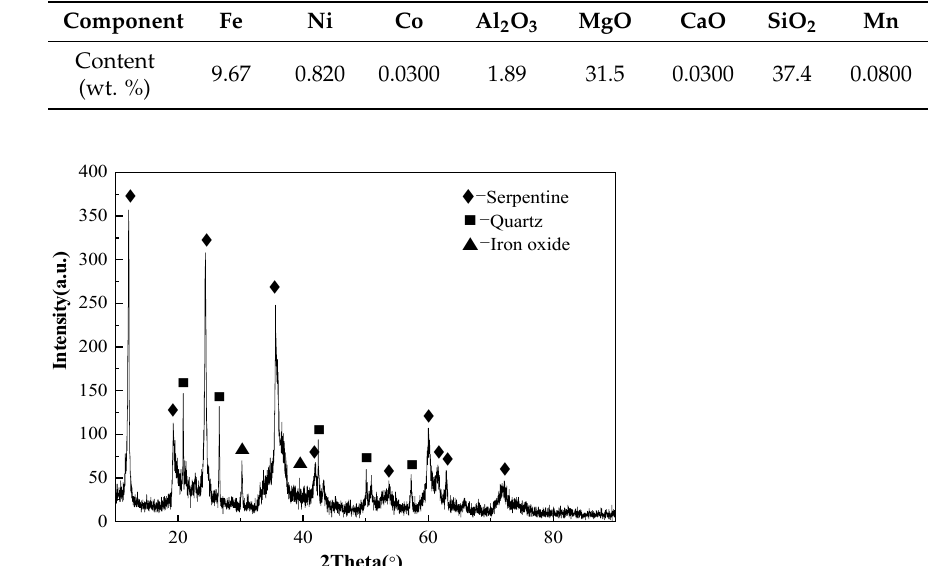
Table 1. Chemical composition of the laterite ore sample.